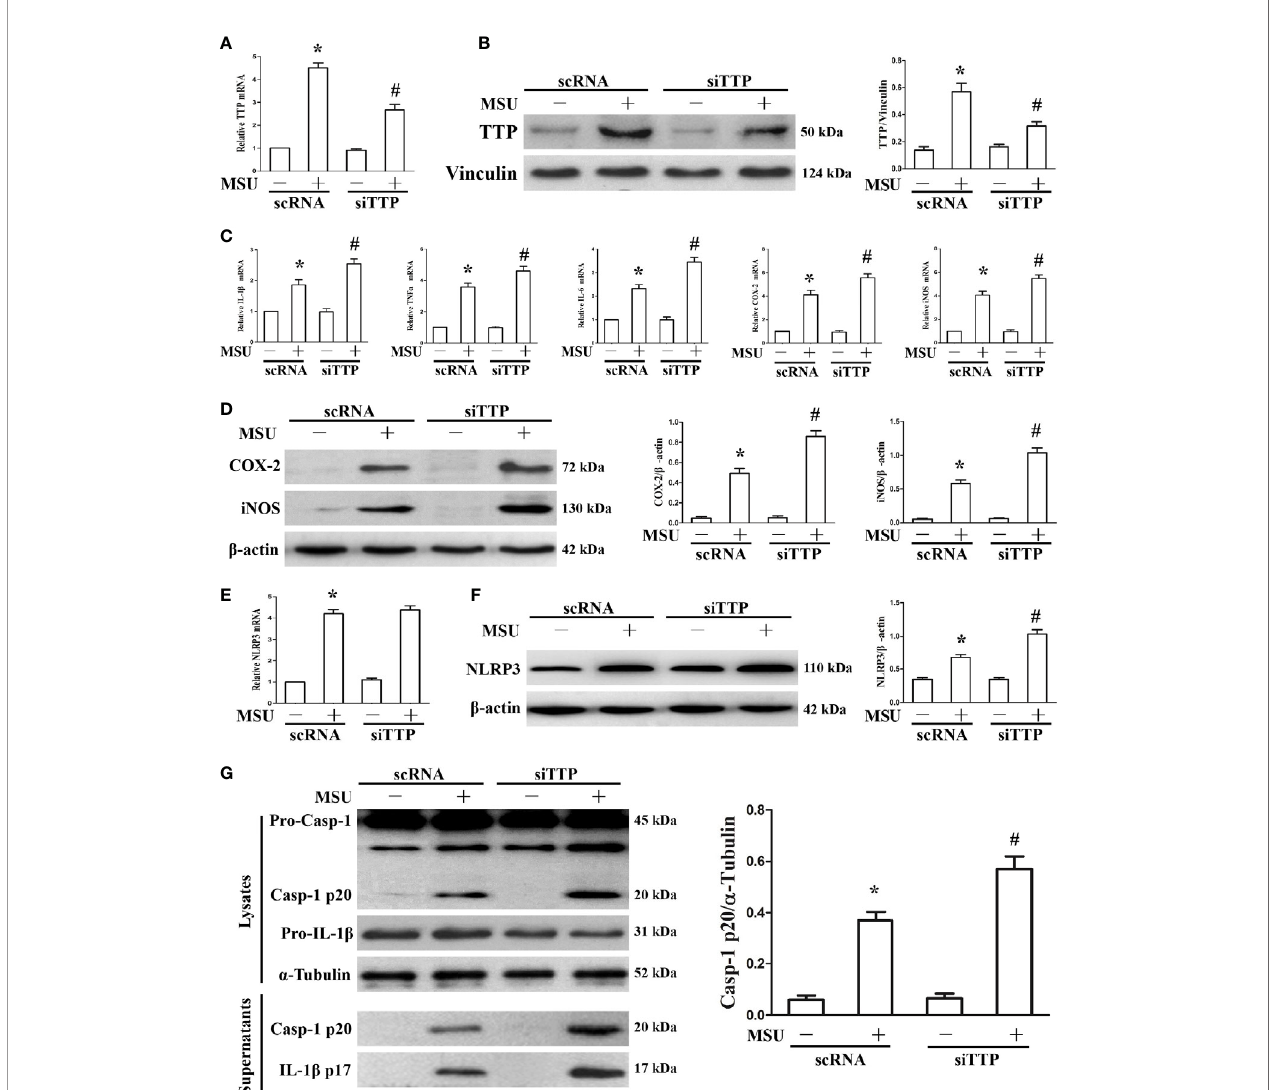
FIGURE 2 | In fl uence of blocking TTP expression on the MSU crystal-induced in fl ammatory response in J774A.1 cells. (A, B) J774A.1 cells were transfected with scramble RNA (scRNA) or TTP-targeted siRNA (siTTP) for 48 h, primed with 100 ng/ml LPS and then stimulated with MSU crystals (50 m g/ml) for 9 h. The knockdown of TTP mRNA and protein expression was con fi rmed by (A) RT-PCR and (B) Western blot (compared to a -tubulin as a loading control). (C) IL-1 b , TNF- a , IL-6, COX-2 and iNOS mRNA expression was measured. (D) Western blot analysis of COX-2 and iNOS protein levels. (E) Effect of TTP knockdown on the NLRP3 mRNA level. (F) Impact of TTP knockdown on the NLRP3 protein level. (G) Effect of TTP knockdown on the protein levels of the p20 subunit of Caspase-1 and IL-1 b in the cell lysates and culture supernatants. All the data are expressed as the means ± SEM from n=3 independent experiments, *P < 0.05 vs. without MSU crystals treatment; # P < 0.05 vs. scRNA transfection + MSU crystals